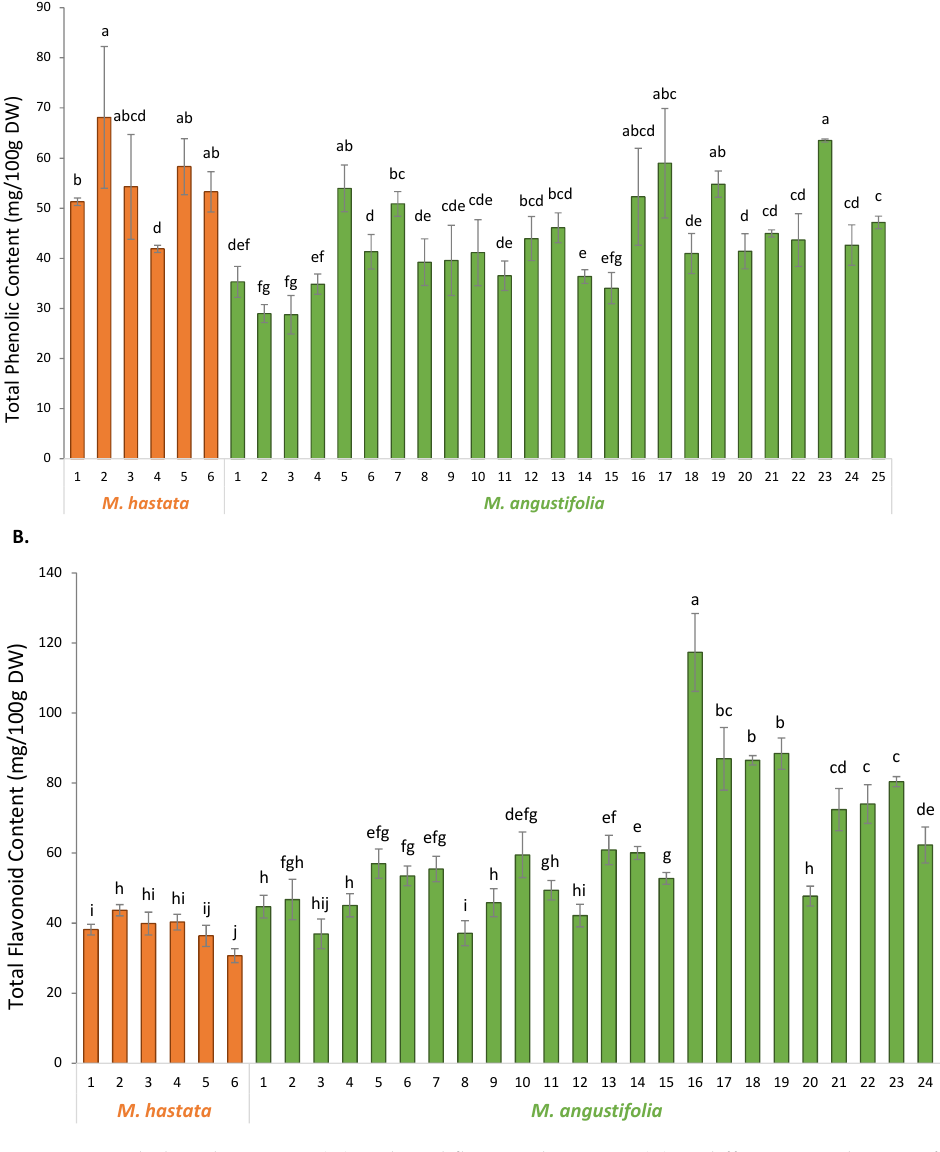
Figure 3. Total phenolic content ( A ) and total flavonoid contents ( B ) in different populations of two Monochoria species including the 6 populations of M. hastata and 25 populations of M. angustifolia ) covering the entire floristic regions from Thailand. Different letters indicate significant differences at p < 0.05. The TPC ranged from 28.78 ± 3.86 (Ma#3) to 63.49 ± 0.29 (Ma#23) mg per 100 g DW gallic acid equivalent in M. angustifolia and ranged from 41.91 ± 0.72 (Mh#4) to 68.12 ± 14.15 (Mh#2) mg per 100 g DW gallic acid equivalents in M. hastata . The TFC, ranged from 36.92 ± 4.26 (Ma#3) to 117.33 ± 11.18 (Ma#16) mg/100 g DW quercetin equivalents in M.